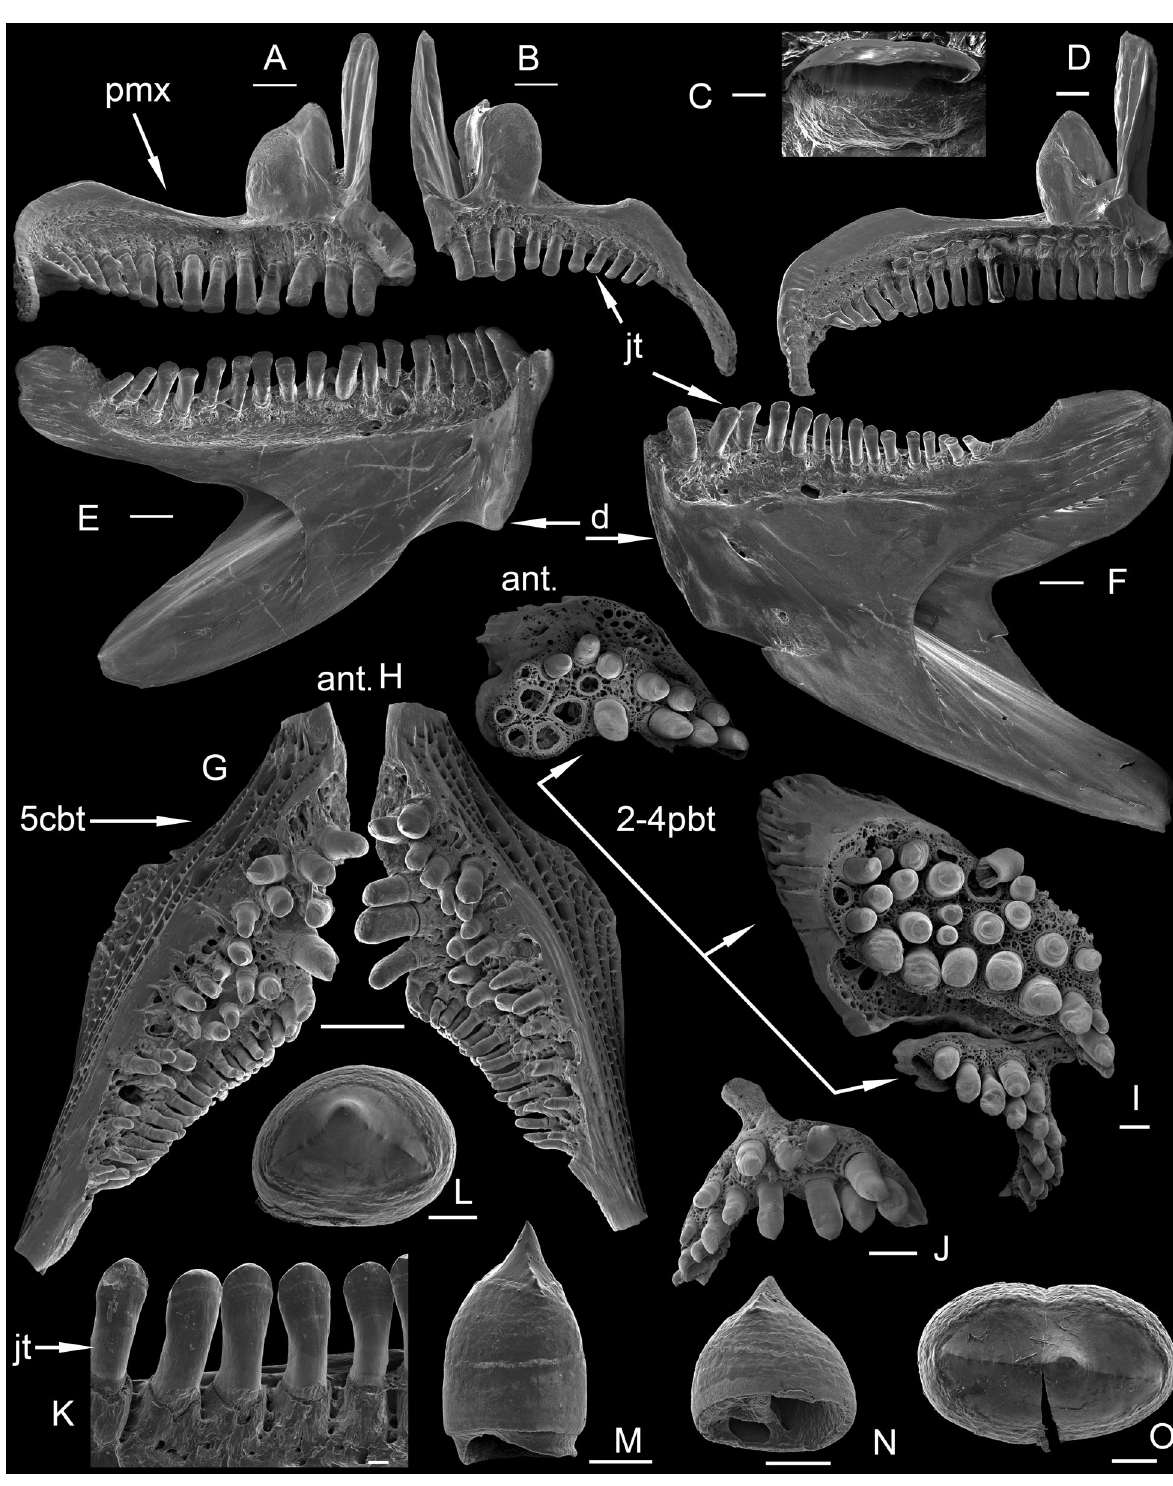
Fig. 6. Platichthys flesus trachurus (Duncker). A , B , lingual aspect of the left and right premaxillae; D , lingual aspect of a left premaxilla with ( C ) close-up of a small tooth from the lingual row; E , F , lingual aspect of the left and right dentaries; G , H , dorsal aspect of the left and right lower pharyngeal tooth plates; I , ventral aspect of the set of the left pharyngobranchial tooth plates; J , a posteriormost right pharyngobranchial tooth plate; K , teeth of the left dentary; L–O , small single teeth from the unknow n position in the mouth. A, GIT 584-123-3-1; B, GIT 584-123-3-2; C = D, GIT 584-138-1-1; E, GIT 584-123-2-1; F, GIT 584-123-2-2; G, GIT 584-93-19-1; H, GIT 584-93-19-2; I, GIT 584-118-21; J, GIT 584-118-18; K, GIT 584-93-1-1; L, GIT 584-93-17; M, GIT 584-93-13; N, GIT 584-93-18; O, GIT 584-93-16. Scale bar for A, B, D–J is 1 mm, for C, K–O 100 μ m. Abbreviations: d, dentary; pmx, premaxilla; jt, jaw teeth. For other abbreviations see Fig.